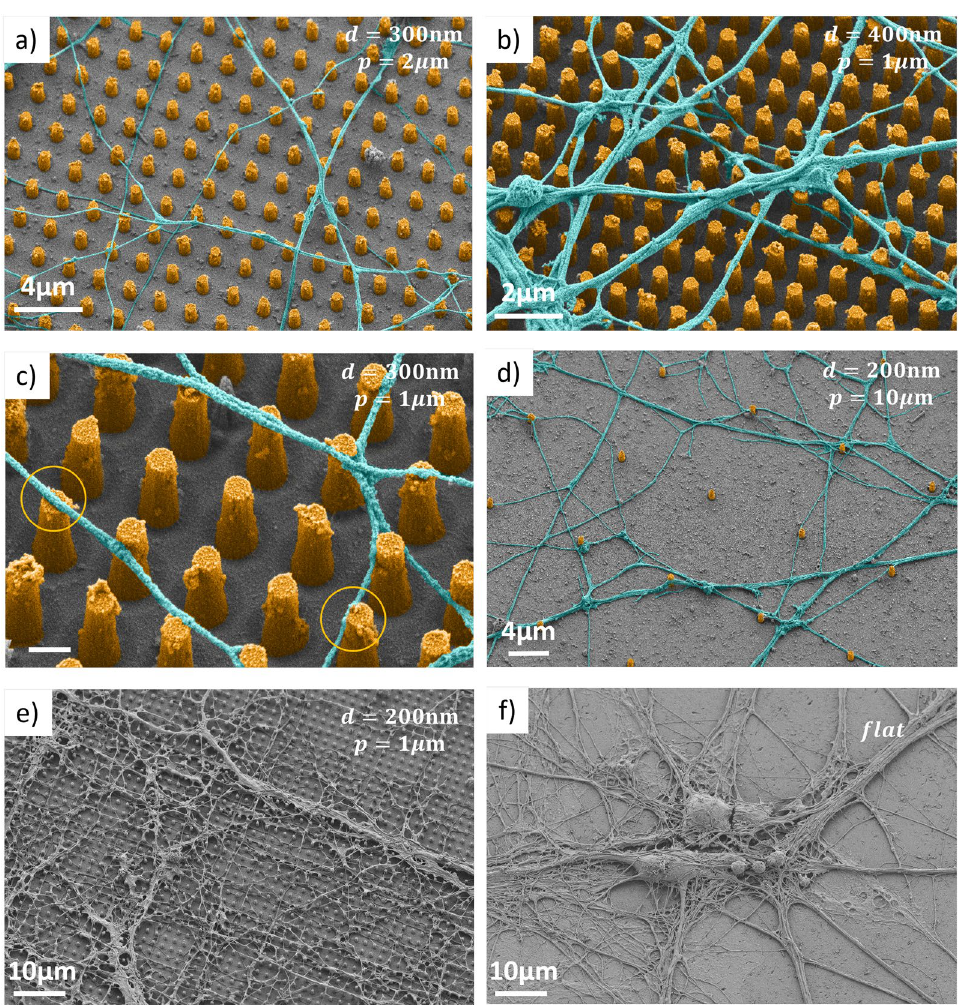
Figure 4. Axon-pillar relative positions. SEM images of primary hippocampal neurons plated on different diamond substrates, at magnification up to × 50k. The samples are tilted by 20 ◦ with respect to horizontal to better appreciate the three-dimensional morphology. In panels ( a–e ) the substrate is nanostructured with pillar arrays (height ∼ 1 µ m, pitch p and diameter d reported in each figure). In panel ( f ) the substrate is flat. Images ( a–d ) have been artificially colored for better